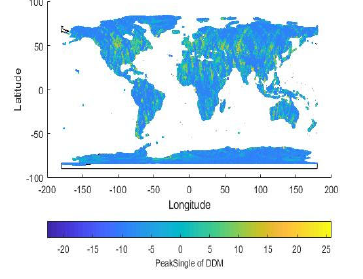
Figure 3. Averaged SNR of DDM for TDS L1B monthly data